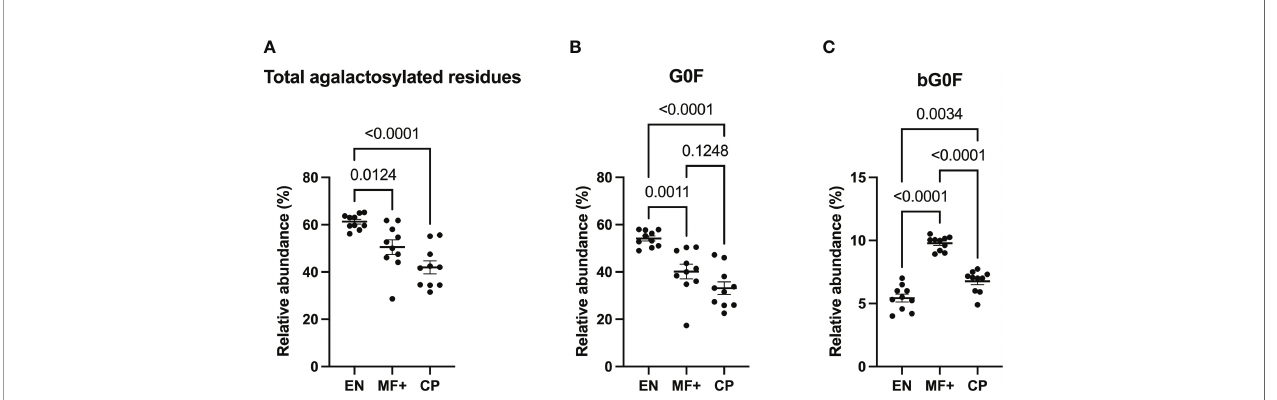
FIGURE 4 | Higher levels of agalactosylated residues in EN. Graphs represent the relative abundance of all IgG-bound glycan structures lacking galactose molecules (A) , agalactosylated and fucosylated (B) or agalactosylated, fucosylated with a bisecting GlcNAc residue (C) in IgG puri fi ed from EN, MF+, and CP patients. Dots represent individual donors. Bars represent means SEM. The indicated p-values refer to the signi fi cance level among all groups according to the Kruskal-Wallis test and Dunn ’ s multiple comparisons test. Signi fi cance is accepted when P < 0.05.